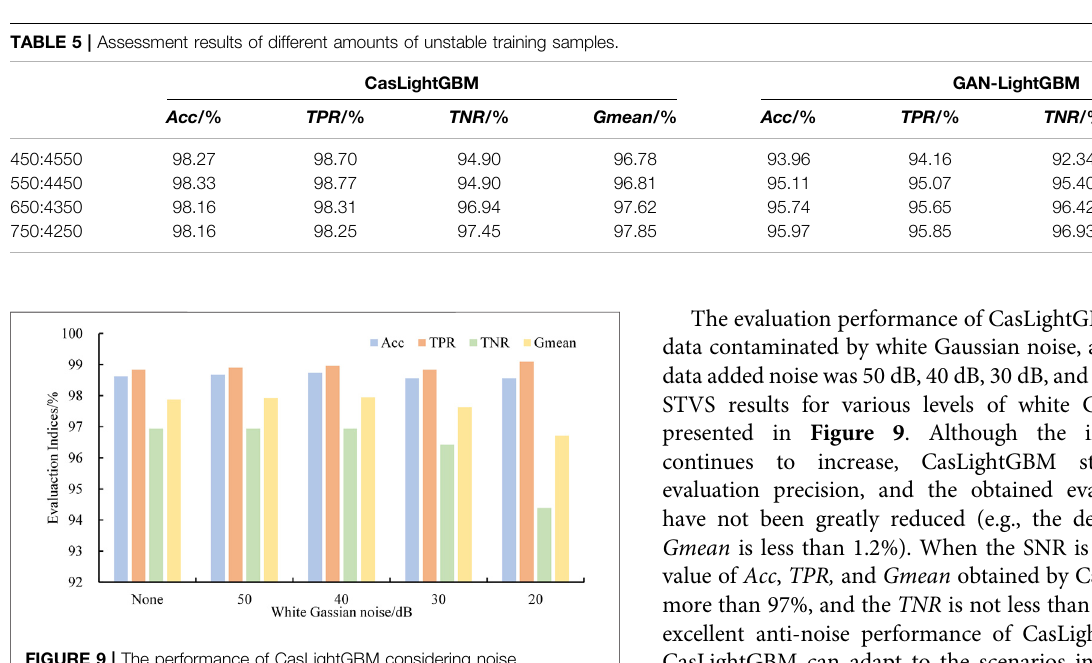
FIGURE 9 | The performance of CasLightGBM considering noise